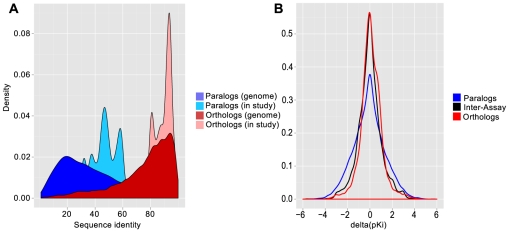
(a) Distributions of pairwise sequence identity between orthologs (red) and paralogs (blue).Distributions in the front represent all pairs retrieved from Ensembl Compara and distributions in the back pairs of targets from our analysis. (b) Distributions of differences in binding affinity between the human target and its rat ortholog (red curve) and distribution of differences in binding affinity between human paralogs (blue curve). For comparison, the distribution of inter-assay differences is outlined (black curve).